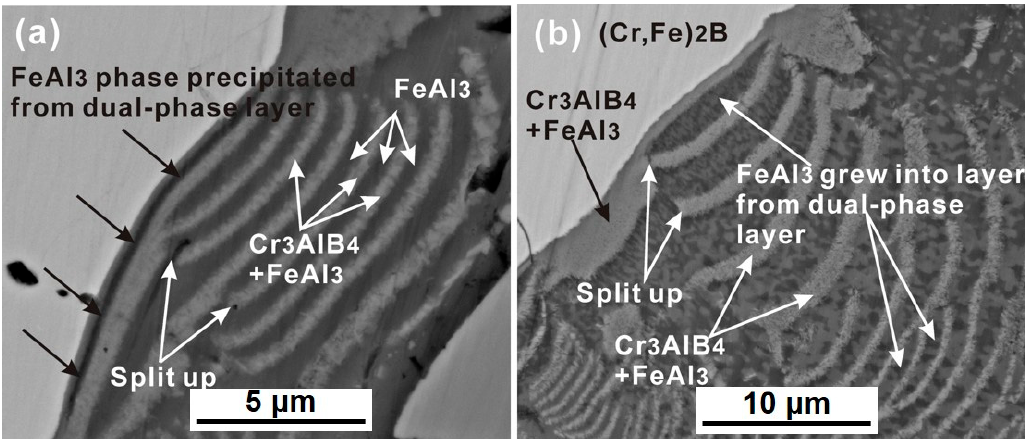
Figure 9. The high-resolution SEM micrographs of the reaction interface within the reaction zone. ( a ) FeAl 3 phase precipitated from the dual-phase layer. ( b ) FeAl 3 grew into new layer from dual-phase layer.